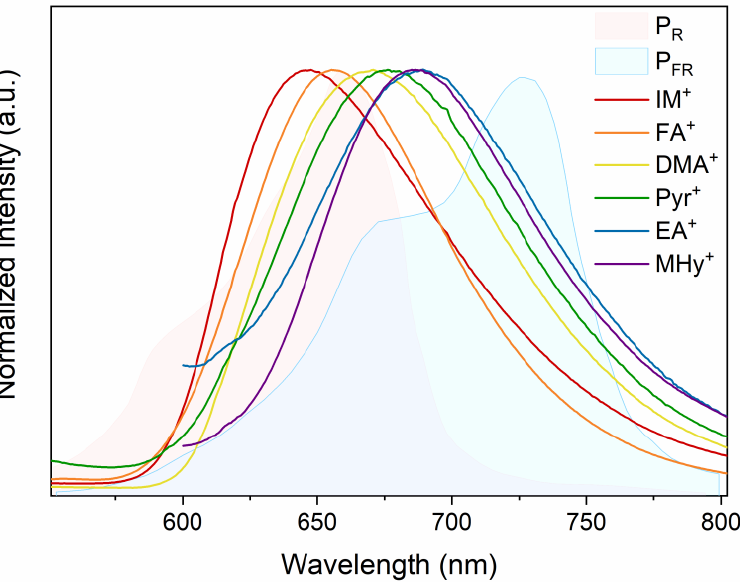
Figure 5. Collation of PL spectra of the investigated manganese hypophosphite and absorption of the P R and P FR phytochromes.